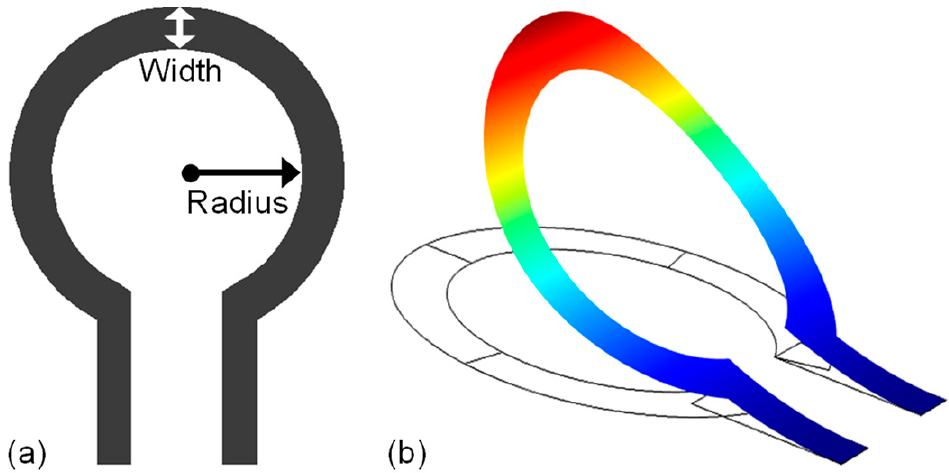
Figure 3. Self-assembled RF-MEMS ring inductor: ( a ) Top view of the planar ring inductor geometry prior to out-of-plane self-assembly; and ( b ) post self-assembly view of the deformed ring inductor.